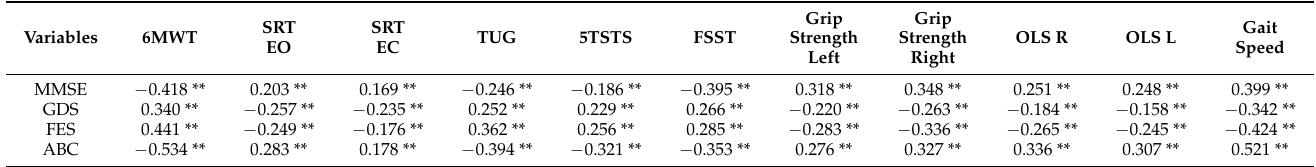
Table 2. A comparison table of the correlation between mental factors and fall risk factors ( n = 393).